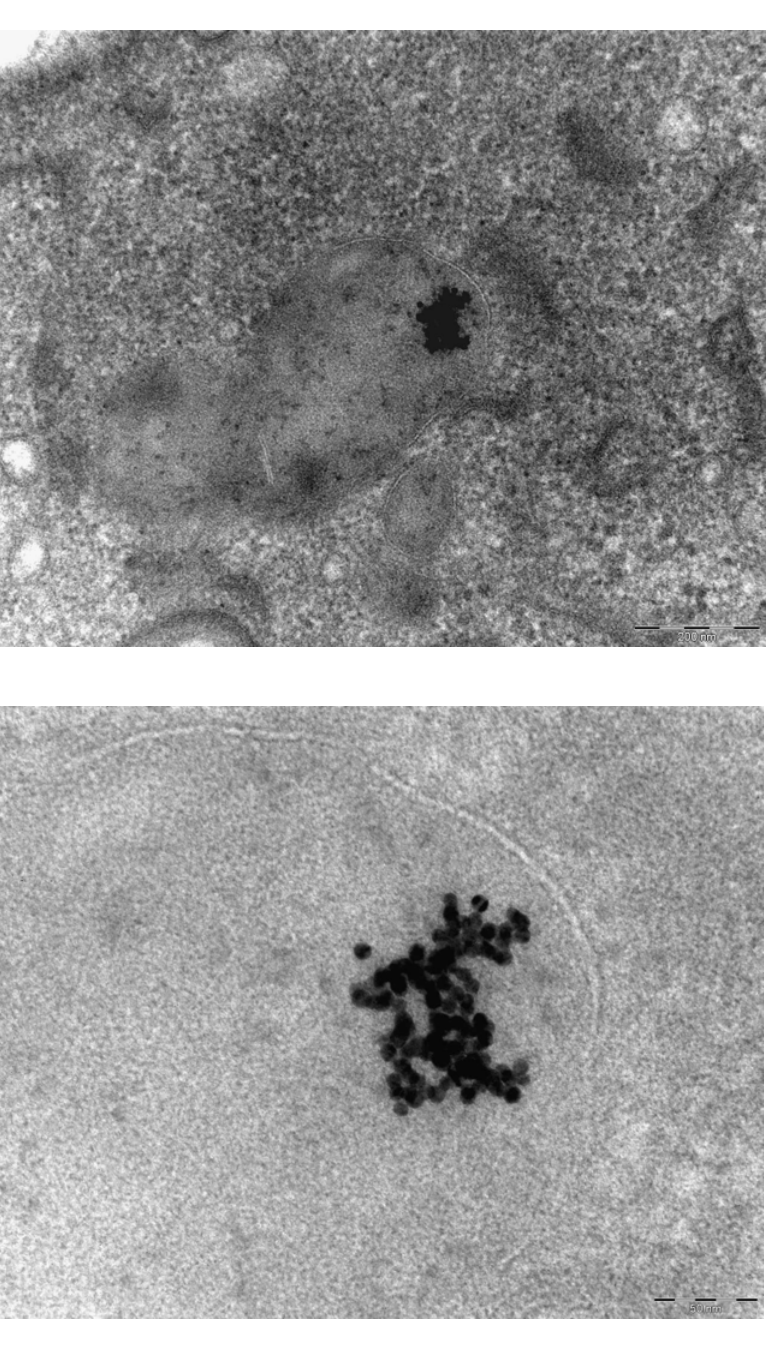
Figure 7. Presence of gold nanoparticles in macrophages of the spleen. Top. Presence of aggregate in macrophage of spleen. The marker indicates 200 nm. Bottom. Detail of aggregate. The marker indicates 50